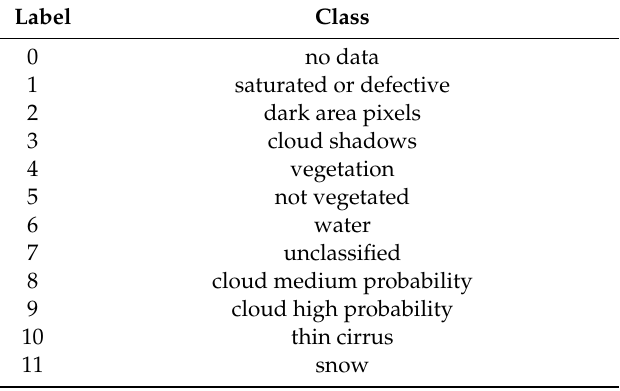
Table 1. Classes of the scene classification map included in Sentinel-2 level 2A products.